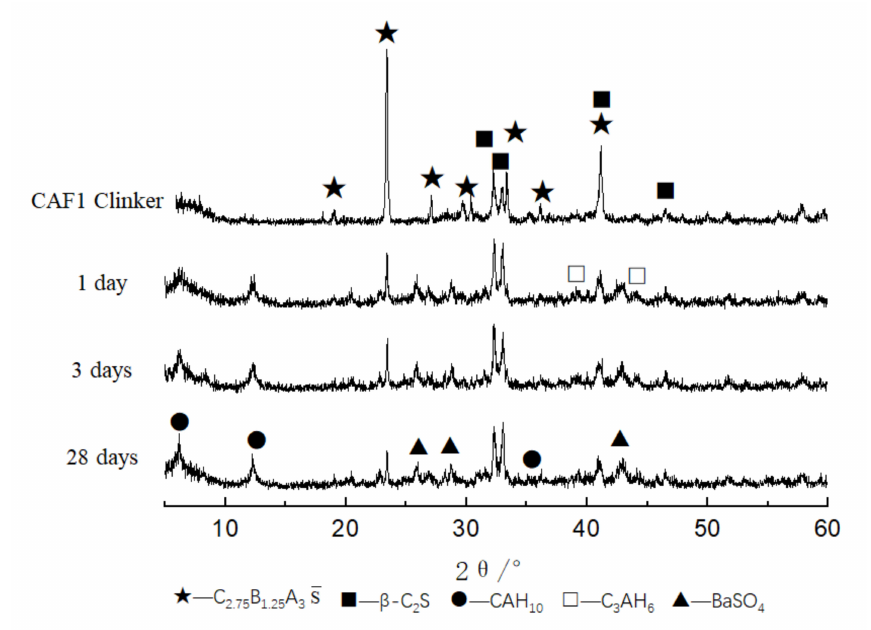
Figure 6. XRD patterns of CAF1 at different curing